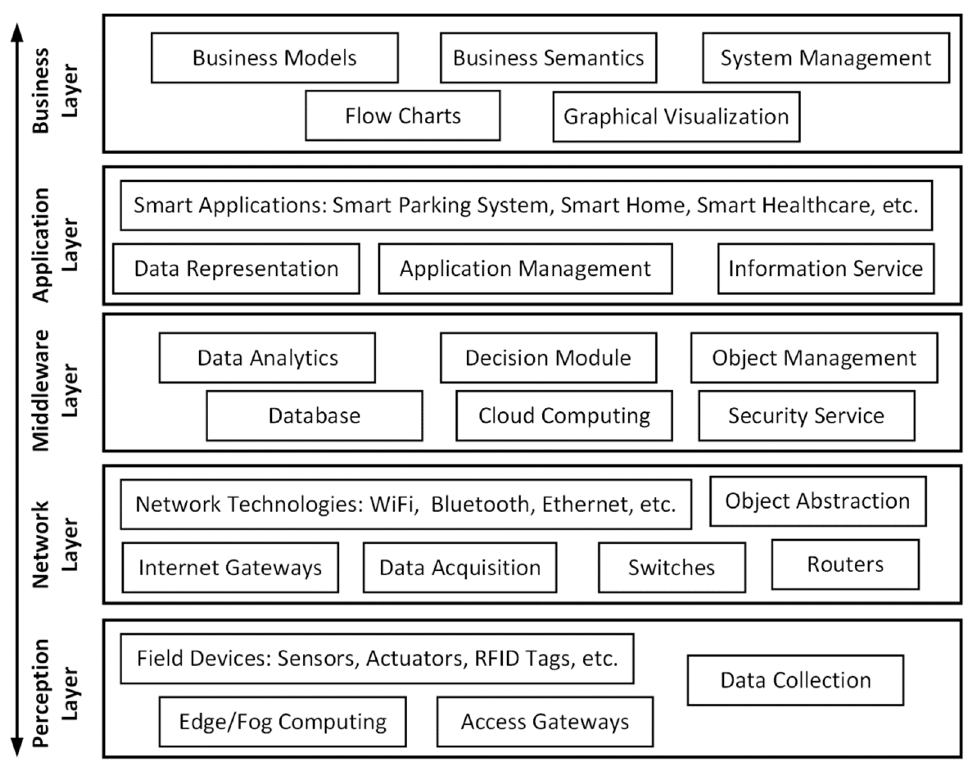
Figure 2. IoT five-layer